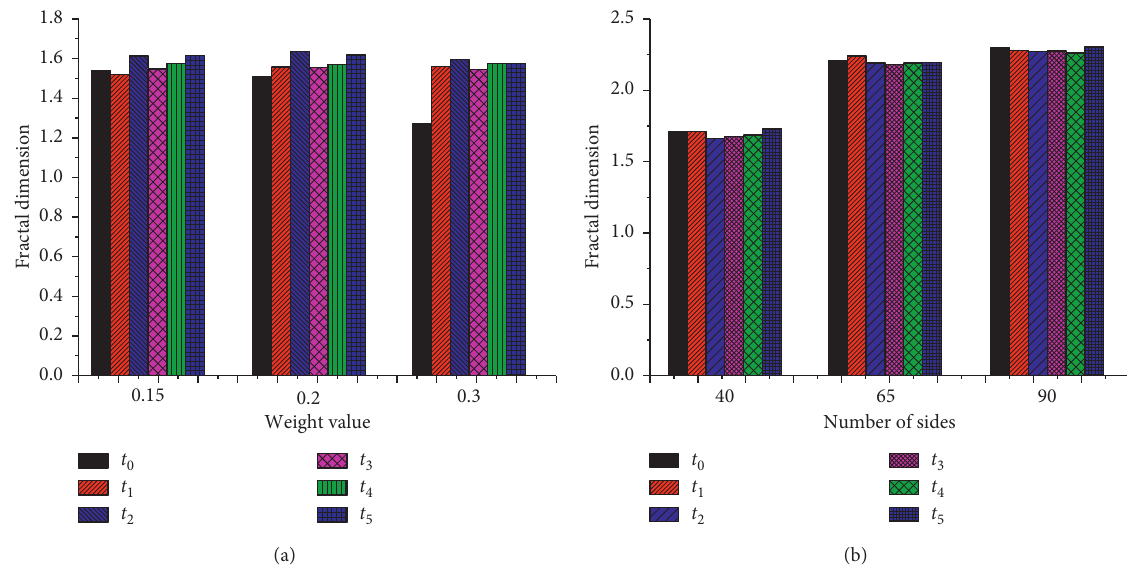
Figure 12: The calculation results of the fractal dimension in the weighted network based on (a) M 1 and (b) M